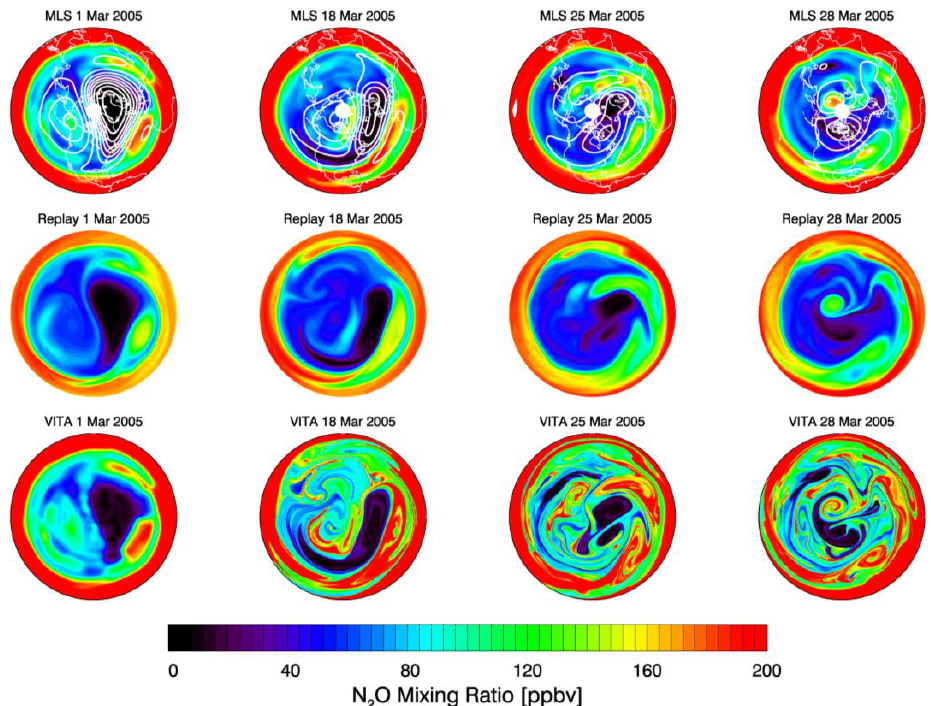
Fig. 4. Northern Hemisphere EOS Aura MLS N 2 O mixing ratio at 850K for 1, 18, 25, and 28 March 2005 overlaid with contours of 10hPa Figure 4. Northern Hemisphere EOS Aura MLS N geopotential height at 250-m intervals (first row). Red (blue) indicates high (low) N 2 O values. Replay N 2 O simulations for the same days (second row). VITA N 2 O simulations initialized on 1 March 2005 (third 28 March 2005 overlaid with contours of 10 hPa geopotential height at 250-m intervals (first 4 row). Red (blue) indicates high (low) N (second row). VITA N